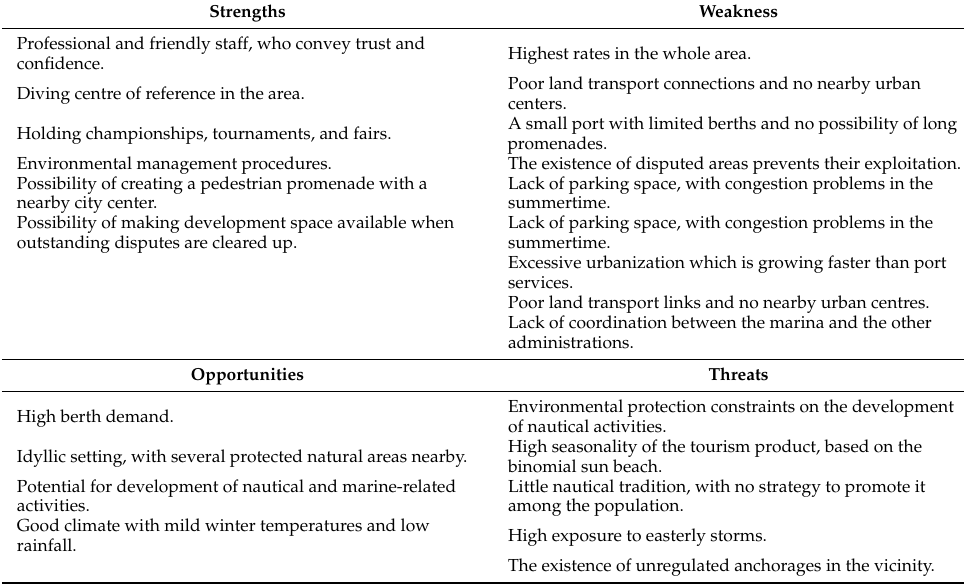
Table 2. SWOT analysis for Marina del Este from stakeholders’ interviews.